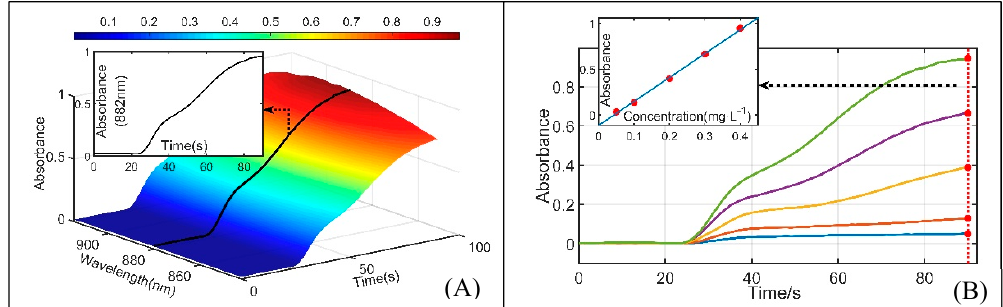
Figure 3. ( A ) Absorbance measurement results over time of incomplete chromogenic reaction; ( B ) absorbance measurement results at characterized band over time and curve fitting of a series of DRP standard solutions at the time of maximum absorbance.